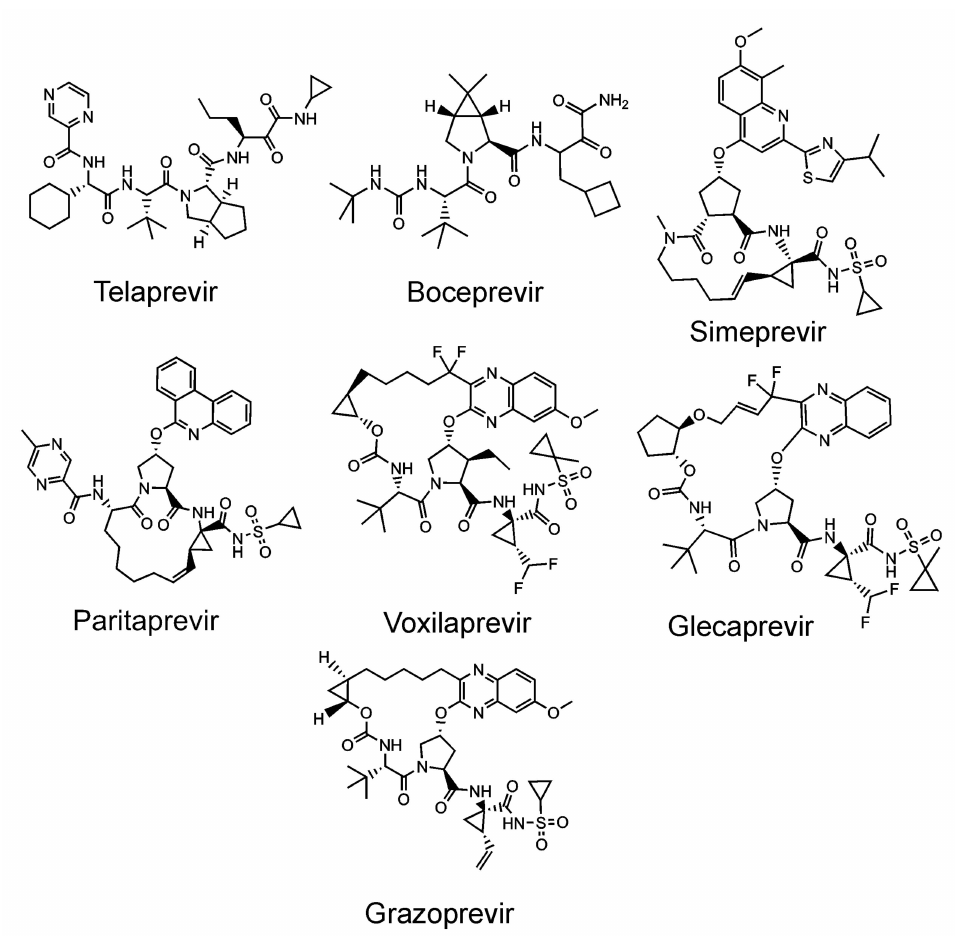
Figure 6. FDA-approved inhibitors of the HCV protease. The flaviviral chaperon-like activating peptide NS2B protrudes from the ER membrane, helping to form a chymotrypsin-like structure within the NS3 protease. [176]. A residual activity of solitary NS3 was reported [177]. The catalytic Ser-His-Asp triad is located in the cleft between two β -barrels [178]. Cleavage between the NS2B and NS3 proteins may not be necessary for proper activity, as during in vitro studies, the NS2B-NS3 protease was active as a fusion protein connected with a polyglycine linker between the NS2B and NS3 domains [179,180]. Compared to the NS2B-NS3 fusion protease, the non-covalently associated heterodimer formed by the NS2B and NS3 subunits might be oriented differently towards the cell membrane or may have some subtle differences in its substrate